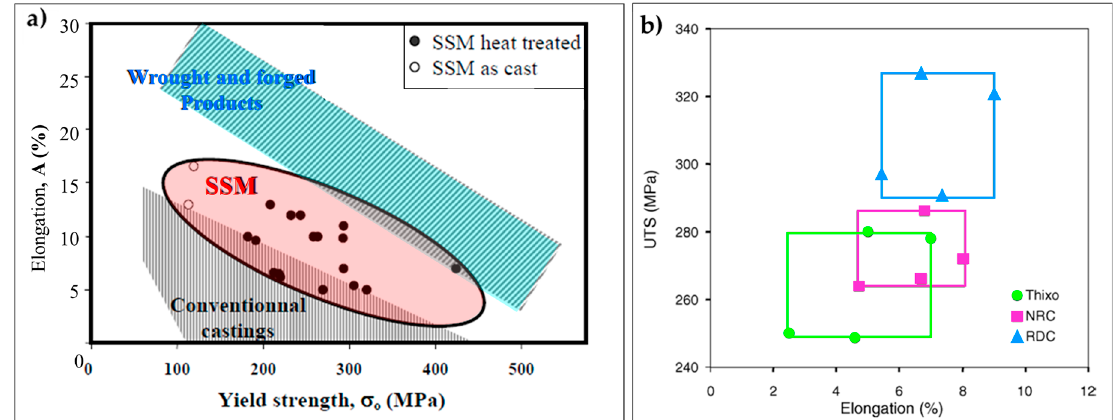
Figure 10. ( a ) Mechanical properties of SSM, cast and forged aluminum alloys [70] and ( b ) comparison of mechanical properties of A357 alloy under T5 condition obtained from different processing technologies [71].